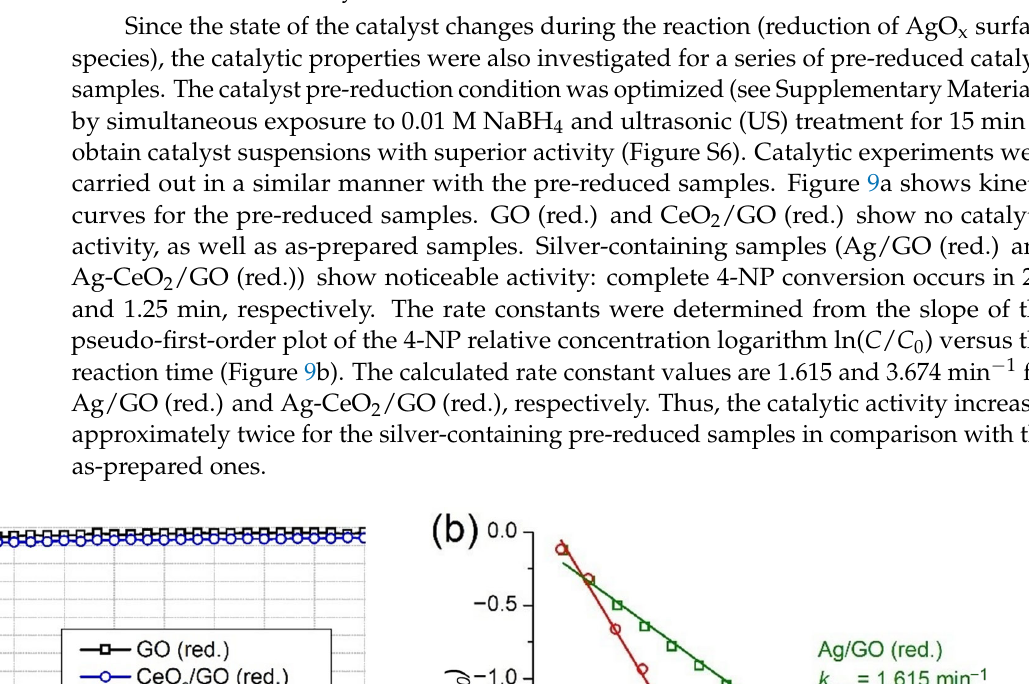
Figure 8. Plot of the 4 ‐ NP relative concentration logarithm ln( C / C 0 ) versus the reaction time at dif ‐ ferent temperatures ( a ) and Arrhenius plot of ln( k ) versus 1000/ T ( b ) for the Ag ‐ CeO 2 /GO catalysts. Experimental conditions: C (4 ‐ NP) = 7.5 × 10 –5 M, C (NaBH 4 ) = 0.015 M, C (catalyst) = 0.015 g/L.